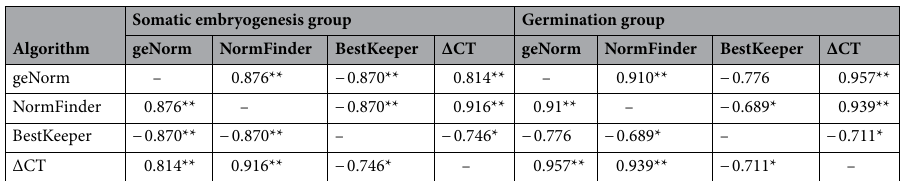
Table 4. Correlations of the four algorithms’ results (r values). *, **Significantly different at the 0.05 and 0.01 levels, respectively.